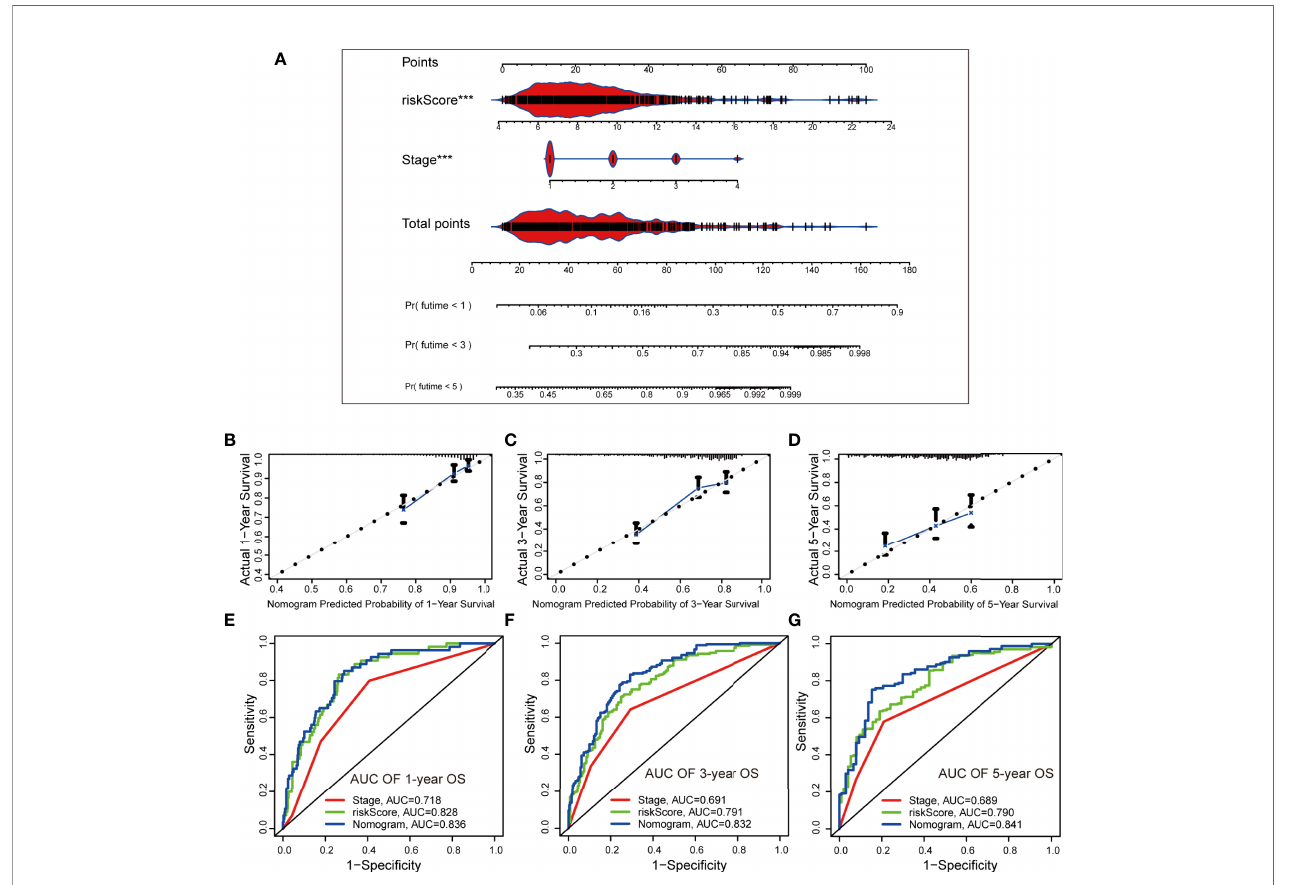
FIGURE 7 | Establishment and evaluation of a nomogram based on independent prognostic factors in The Cancer Genome Atlas cohort. (A) The nomogram generated from independent prognostic factors predicts the overall survival (OS) of patients with lung adenocarcinoma. (B – D) Calibration plot analyses for the predictive value of prognostic factors. (E – G) Comparison of receiver operating characteristic curves of independent prognostic factors in predicting 1-, 3-, and 5-year OS. *** P <